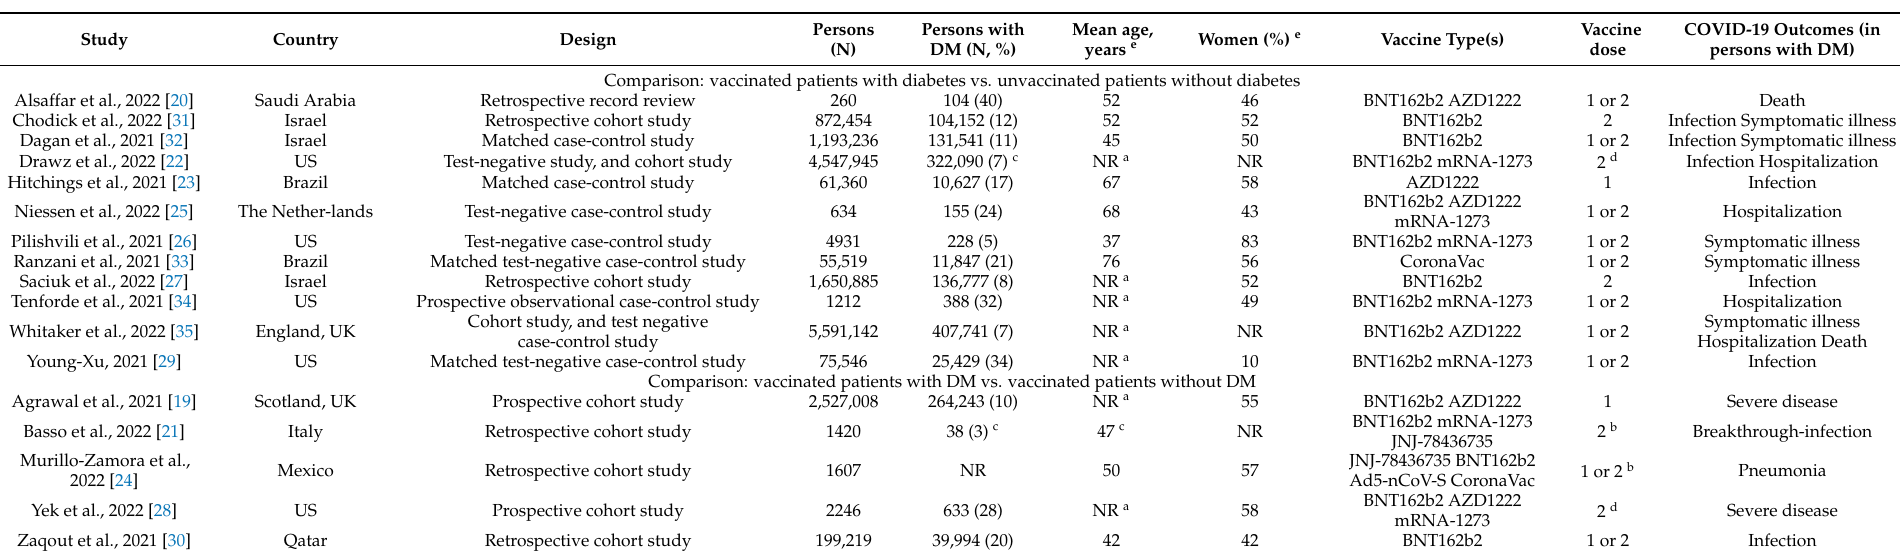
Table 1. Characteristics of included